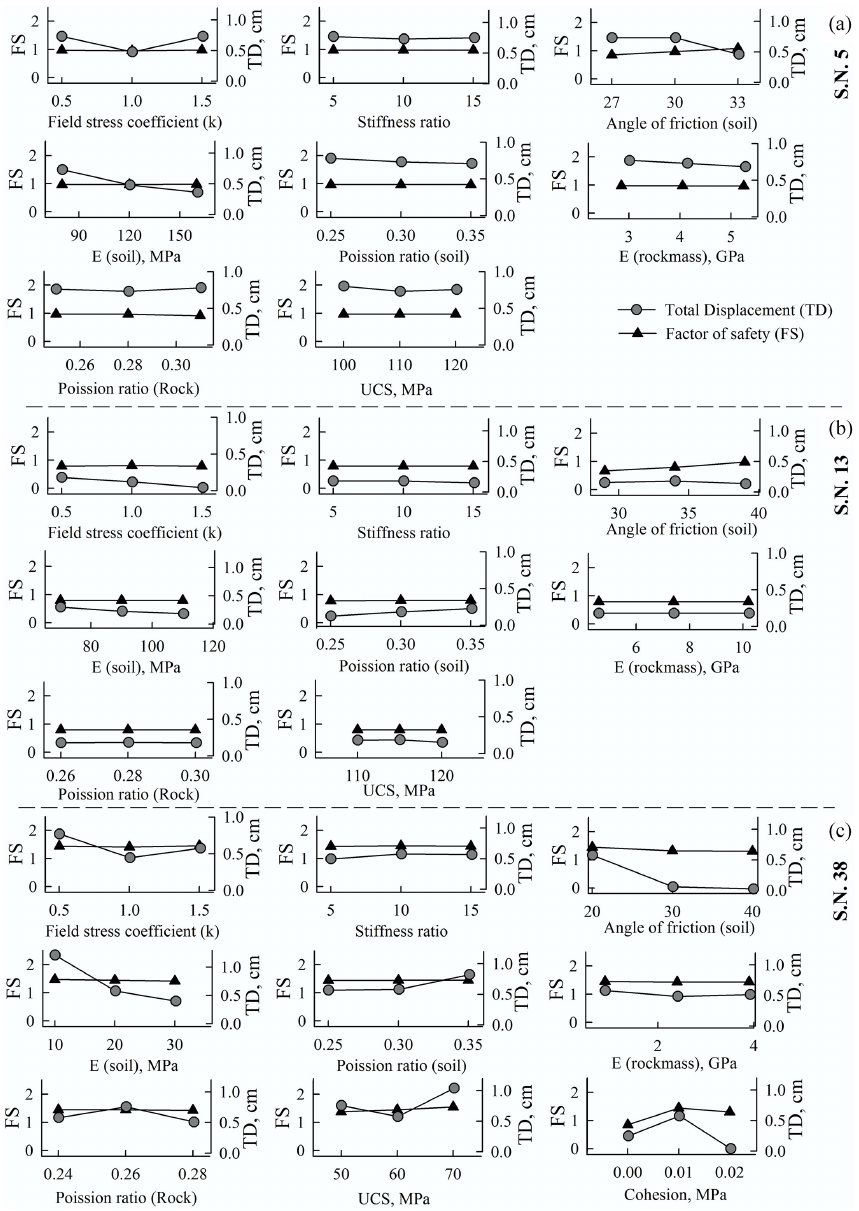
Figure 6. Parametric analysis of debris slides: (a) Akpa_III (no. 5), (b) Pangi_III (no. 13), and (c) Barauni Gad_I_S (no. 38). No. refers to the serial no. of landslides in Table